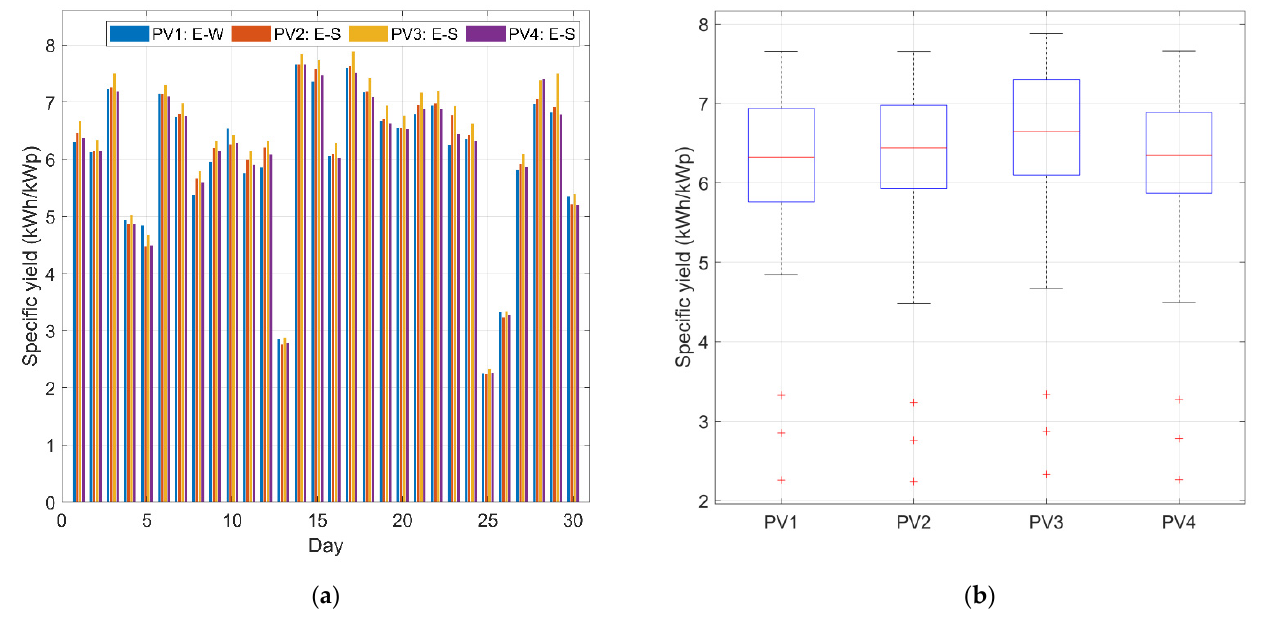
Figure 2. ( a ) Bar chart and ( b ) box plot of daily specific yields of the PV1–PV4 systems in June 2021.